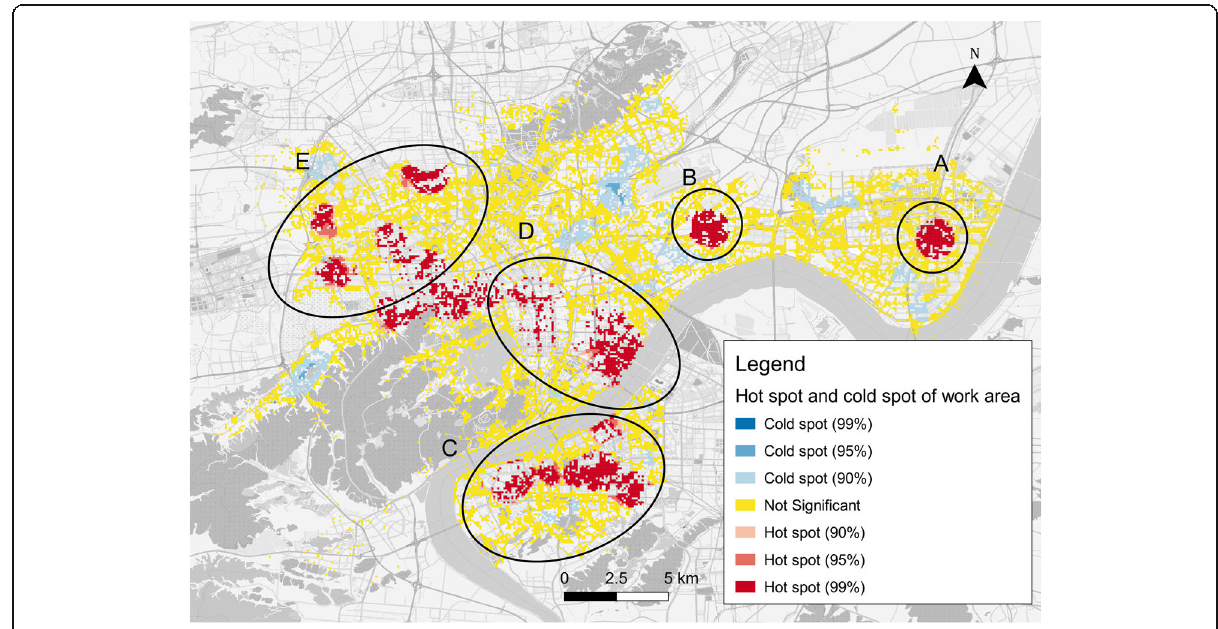
Fig. 8 Hot spot and cold spot of work area in the study